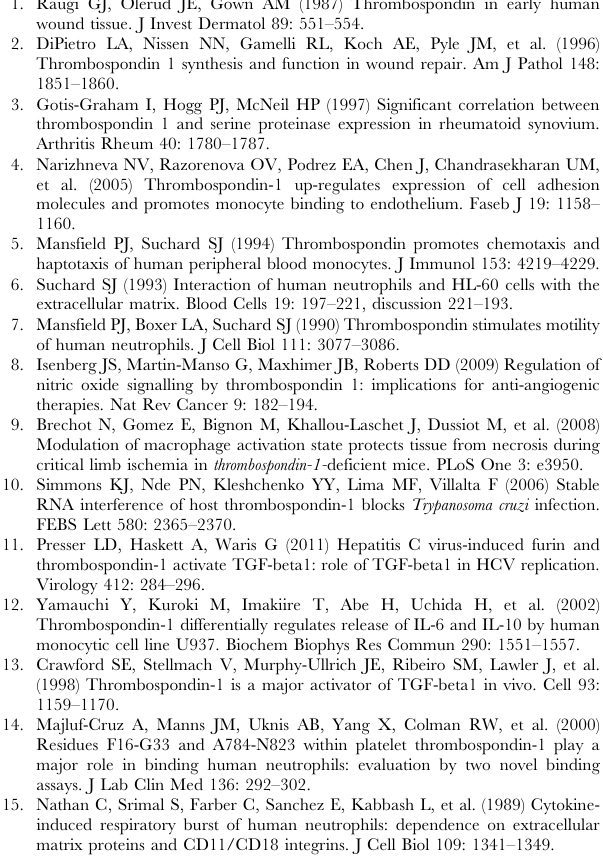
Figure S4 Flow Cytometric analysis of splenocytes subpopulations from naı¨ve tsp1 2 / 2 and wt C57BL/6 mice. Single cell suspensions were prepared from spleens, and their surface antigens were stained using a broad panel of monoclonal antibodies (anti-CD4, -CD8, -CD19, -CD3, -CD11b from BD PharMingen). Cell samples were analyzed by three-color Flow Cytometry with a BD FACScaliber instrument and CellQuest Software. Data are expressed as means 6 SEM,